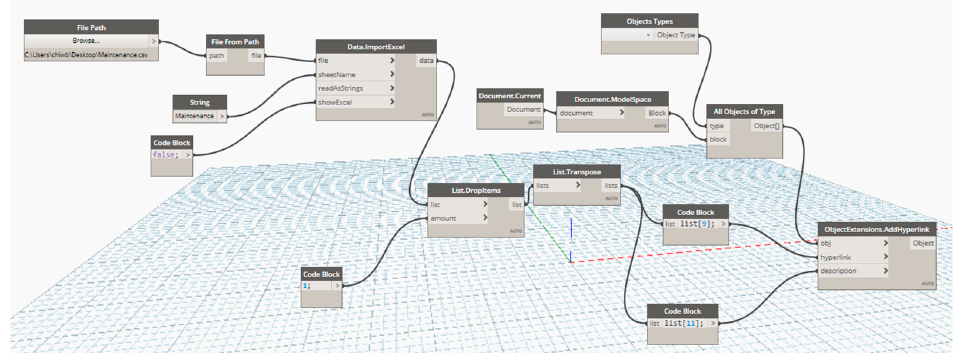
Figure 3. Dynamo for information exchange.